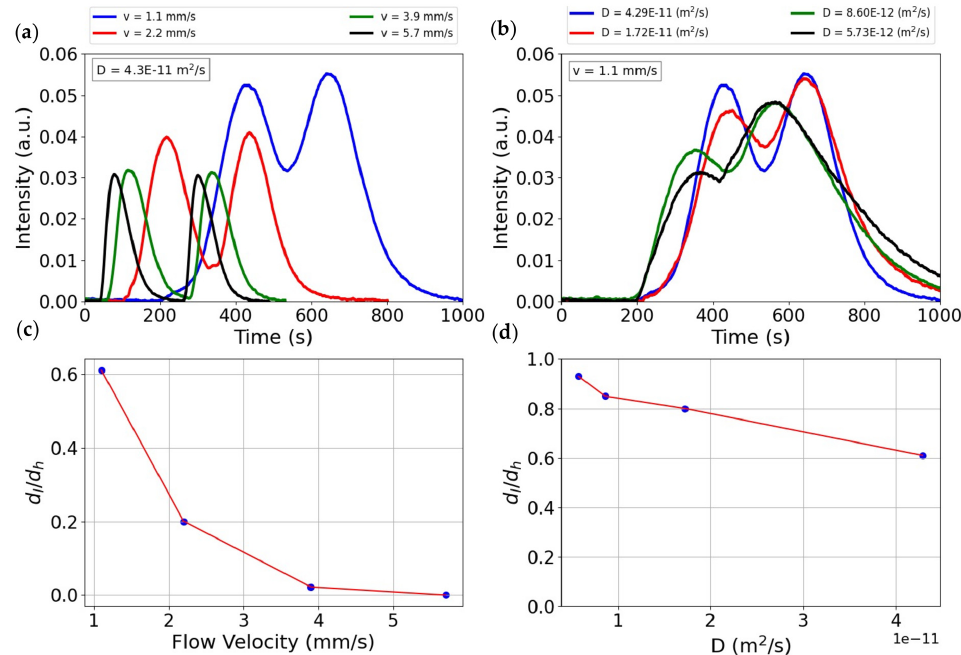
Figure 9. ( a , b ) Experimental signals representing two consecutive bits with a fixed delay between them of 220 seconds, colors are associated with different values of flow velocity and diffusion coefficient, respectively; ( c , d ) development of the d l /d h ratio as a function of flow velocity and diffusion coefficient,